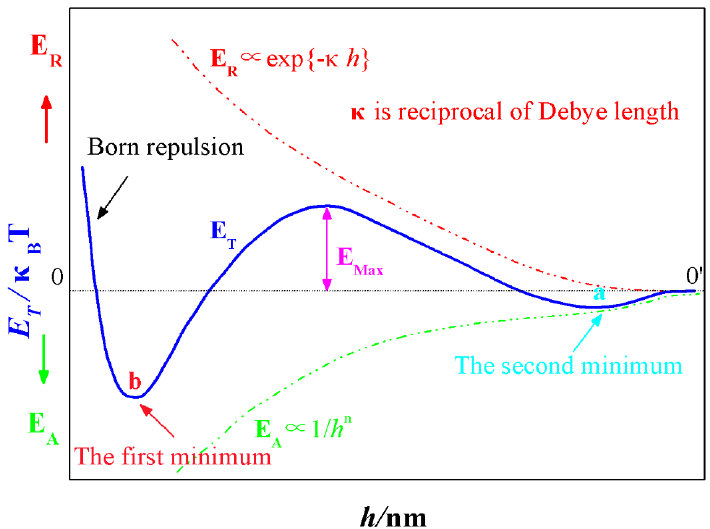
Figure 1. The interaction energy of colloidal particles as a function of their separation distance h.